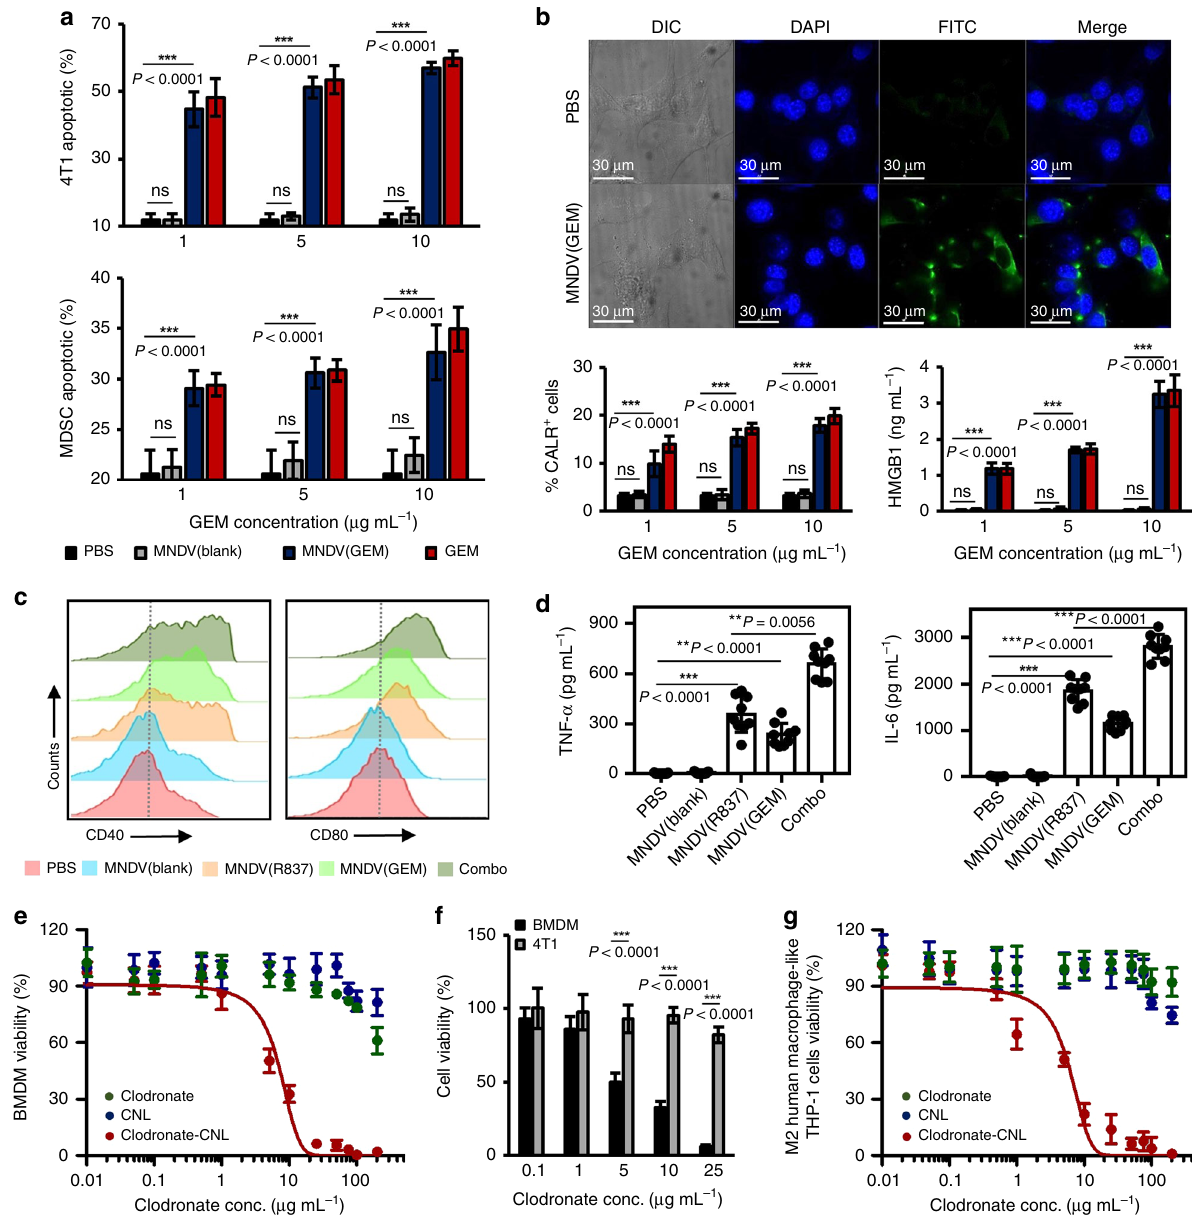
Fig. 3 In vitro test of induction of an in situ cancer vaccine and depletion of immunosuppressive cells. a In vitro test of MNDV(GEM)-induced apoptosis. Percentage of apoptotic 4T1 cells (upper) and MDSCs (lower) (Annexin-V and PI double-positive cells). b MNDV(GEM) induced immunogenic changes in 4T1 cells. Representative fl uorescence images showing the induction of CALR expression in 4T1 cells in the presence of MNDV(GEM) for 4 h. The cell nuclei and CALR were detected by Hoechst and anti-CALR/FITC-conjugated anti-IgG antibodies staining, respectively. Flow cytometry analysis of CALR + 4T1 cells. HMGB1 release into the supernatants of MNDV(GEM)-treated 4T1 cell cultures was examined by ELISA 24 h after treatment. c Histograms representing the cell surface expression of activation and maturation markers in BMDCs following treatment with MNDV(R837), MNDV(GEM) (MNDV (GEM)-treated 4T1 cell-conditioned media), or Combo. d Quanti fi cation of IL-6 and TNF- α production via ELISA following the treatment. P- values were determined by one-way ANOVA and Tukey ’ s test. e Concentration-dependent cytotoxicity of clodronate-CNLs to BMDMs. f Cytotoxicity of clodronate- CNLs to BMDMs and 4T1 cells. P- values were determined by Student ’ s t -test. g Concentration-dependent cytotoxicity of clodronate-CNLs to human M2 macrophage-like THP-1 cells. Viability of the treated cells was assessed by MTS assay. Data are each pooled from three independent experiments